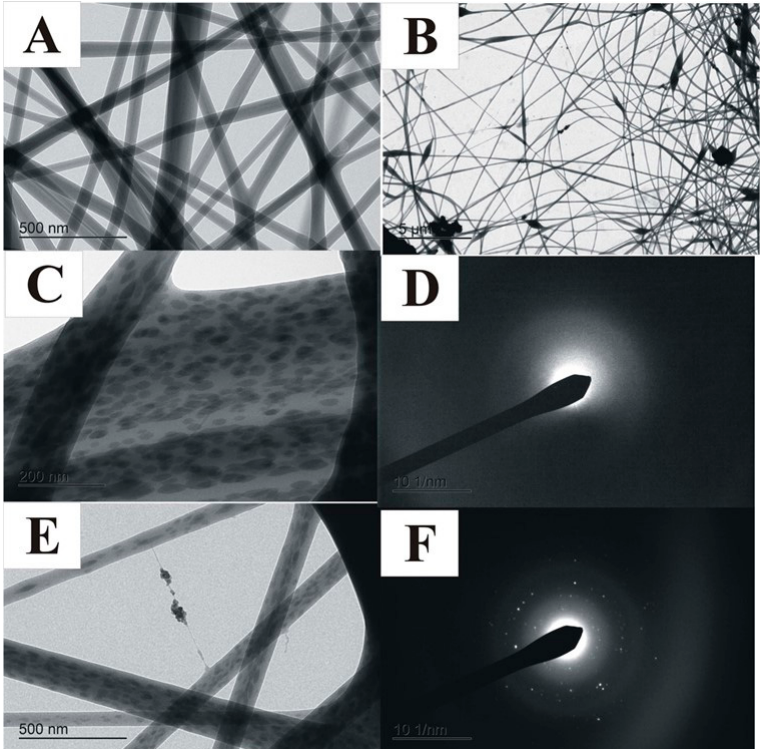
Figure 2. ( A ) TEM image from (PVOH/GG/CA/AZO-Np) (5/2/0.7/0.5) ( w / w ) % fibers mixture protocol with sonication. ( B ) TEM image from (PVOH/GG/CA/AZO-Np) (5/2/0.7/1) ( w / w ) % fibers with the same mixture protocol as ( A ). ( C ) TEM image from (PVOH/GG/CA/AZO-Np) (5/2/0.7/1) ( w / w ) % fibers without sonication. Black ellipsoidal spots are seen on fiber surface, 30 kX. ( D ) Corresponding diffraction pattern on the spot ( C ). ( E ) TEM image from (PVOH/GG/CA/AZO-Np) (5/2/0.7/1) ( w / w ) % fibers, nanoparticles are seen, 15 kX. ( F ) Corresponding diffraction pattern on the spot ( E ).